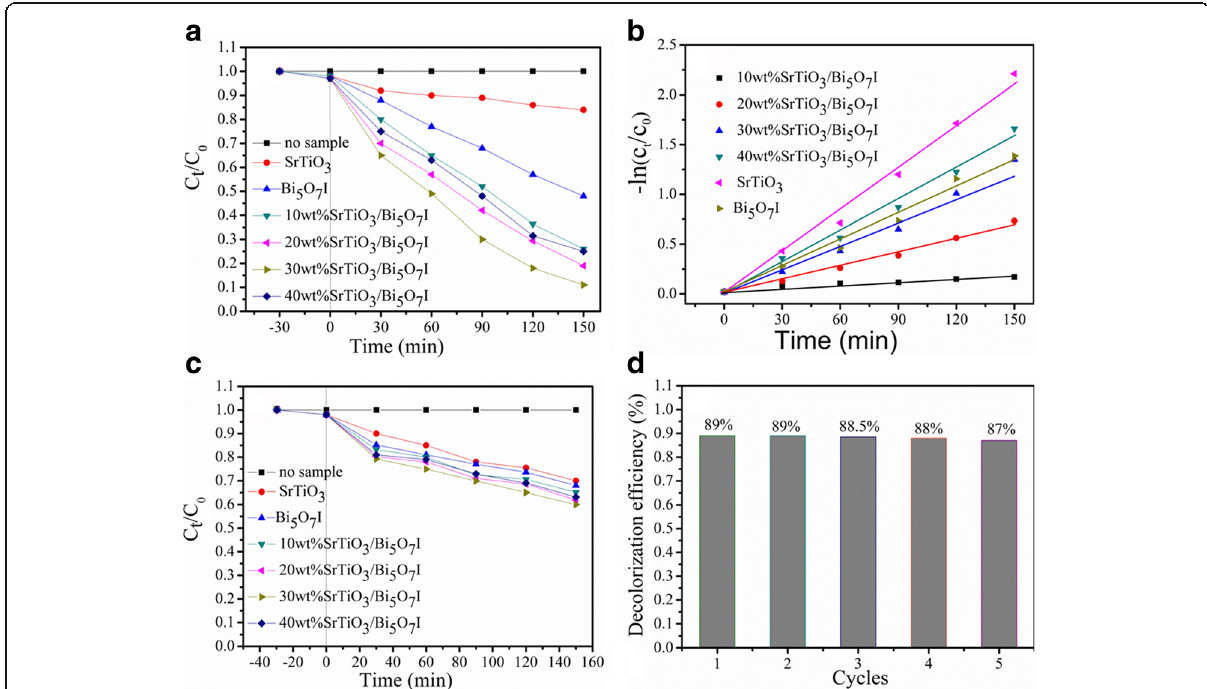
Fig. 6 a Photocatalytic degradation of RhB solution for all samples under simulated solar light irradiation. b Plots of -ln(C t /C 0 ) vs time for all samples. c Photocatalytic degradation of RhB solution for all samples under UV light illumination. d Cycling degradation efficiency of RhB over the SrTiO 3 /Bi 5 O 7 I nanocomposites